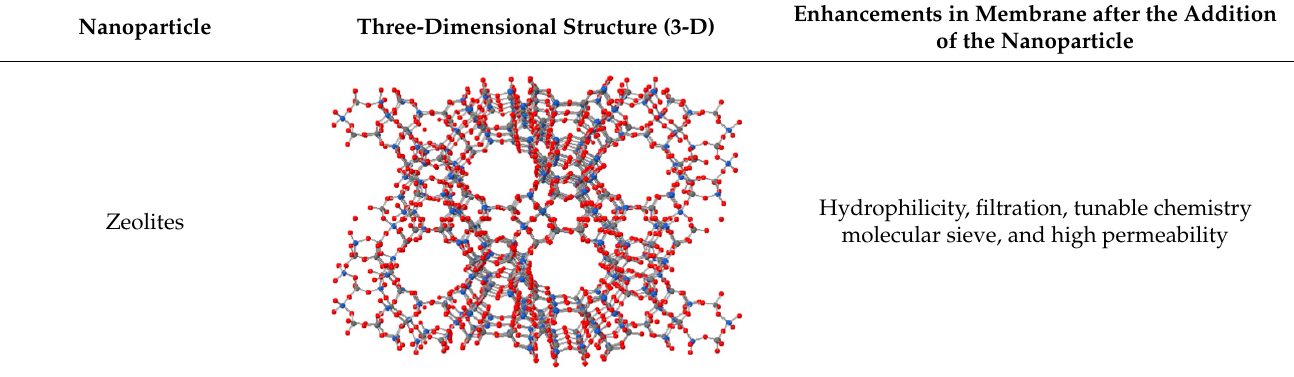
Table 1. Three-dimensional structures and membrane enhancements for some widely used nanoparticles in membranes. Nanoparticle Three-Dimensional Structure (3-D)